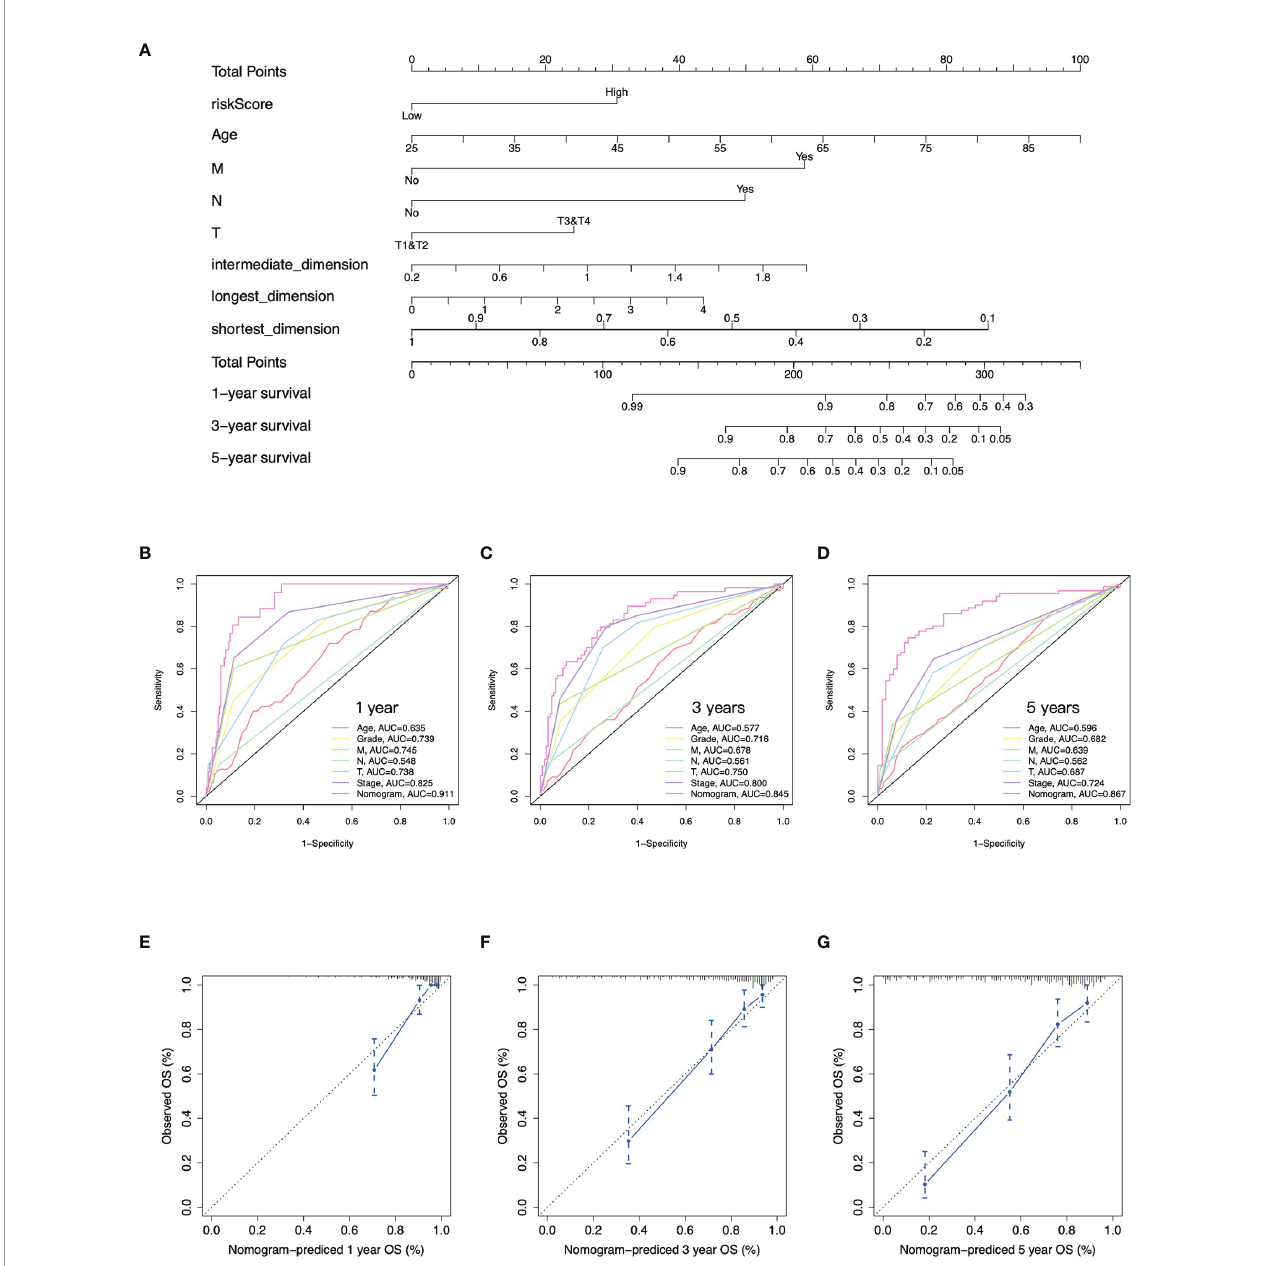
FIGURE 4 | Construction of nomogram. (A) Nomogram to predict overall survival at 1, 3, and 5 years based on the gene signature, age, pathology T, N, and M stages, and tumor size. (B – D) Time-dependent ROC curves at 1, 3, and 5 years of the nomogram and clinical features of ccRCC. (E – G) Calibration curves of nomogram for predicting overall survival at 1, 3, and 5